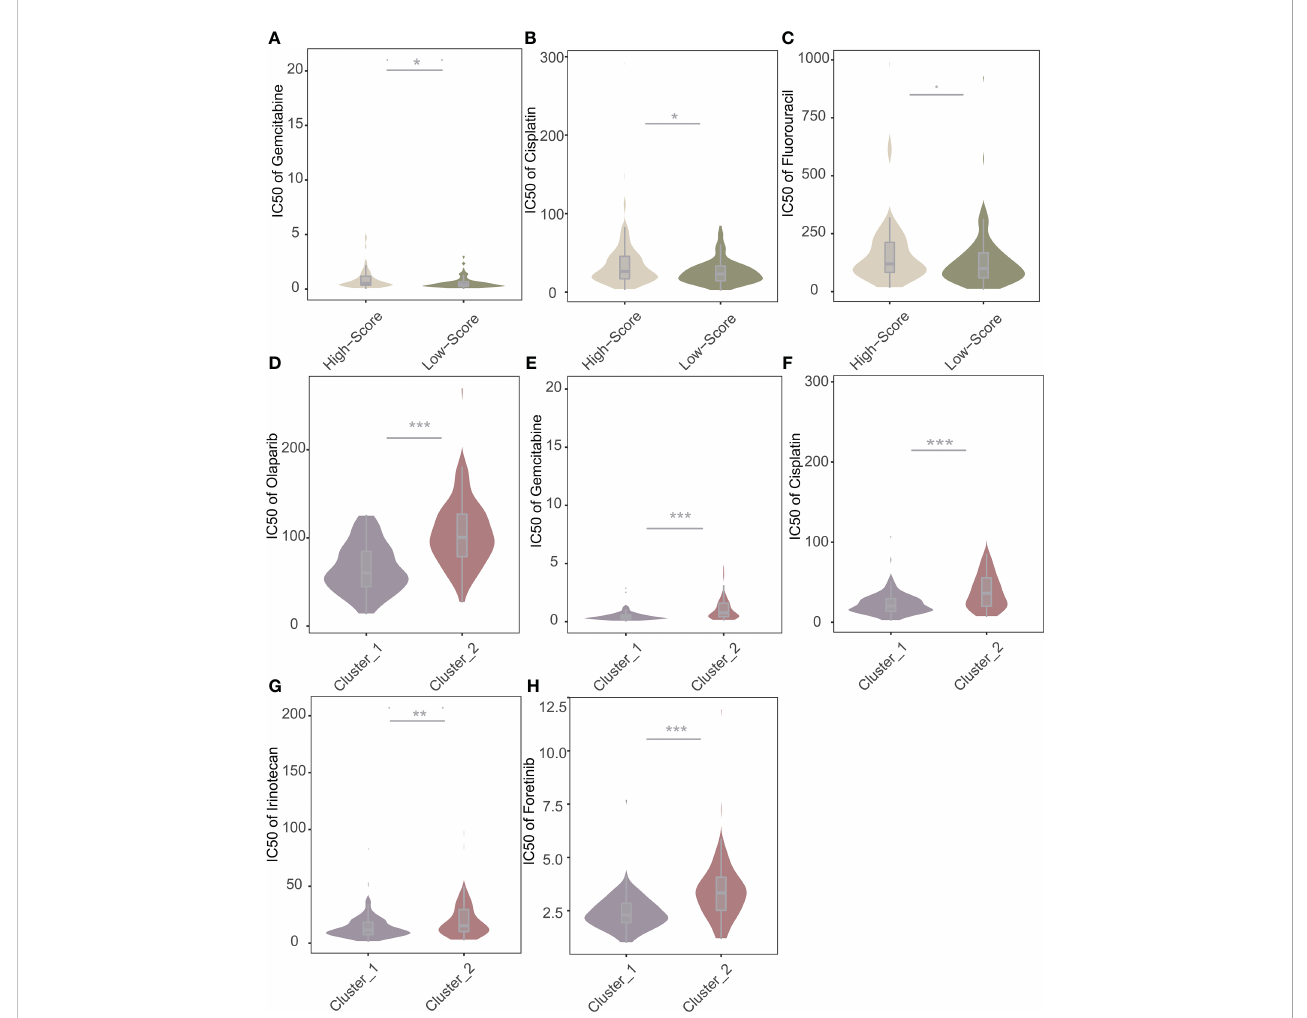
FIGURE 10 Predictive value of NRS Score and immune subtypes for therapeutic response of chemotherapeutic agents. (A) Comparisons of IC50 of Gemcitabine for chemotherapeutics and targeted therapy drugs between two score strati fi cations. (B) Comparisons of IC50 of Cisplatin for chemotherapeutics and targeted therapy drugs between two score strati fi cations. (C) Comparisons of IC50 of Fluorouracil for chemotherapeutics and targeted therapy drugs between two score strati fi cations. (D) Comparisons of IC50 of Olaparib for chemotherapeutics and targeted therapy drugs between two immune subtypes. (E) Comparisons of IC50 of Gemcitabine for chemotherapeutics and targeted therapy drugs between two immune subtypes. (F) Comparisons of IC50 of Cisplatin for chemotherapeutics and targeted therapy drugs between two immune subtypes. (G) Comparisons of IC50 of Irinotecan for chemotherapeutics and targeted therapy drugs between two immune subtypes. (H) Comparisons of IC50 of Foretinib for chemotherapeutics and targeted therapy drugs between two immune subtypes. *p < 0.05, **p < 0.01, ***p <